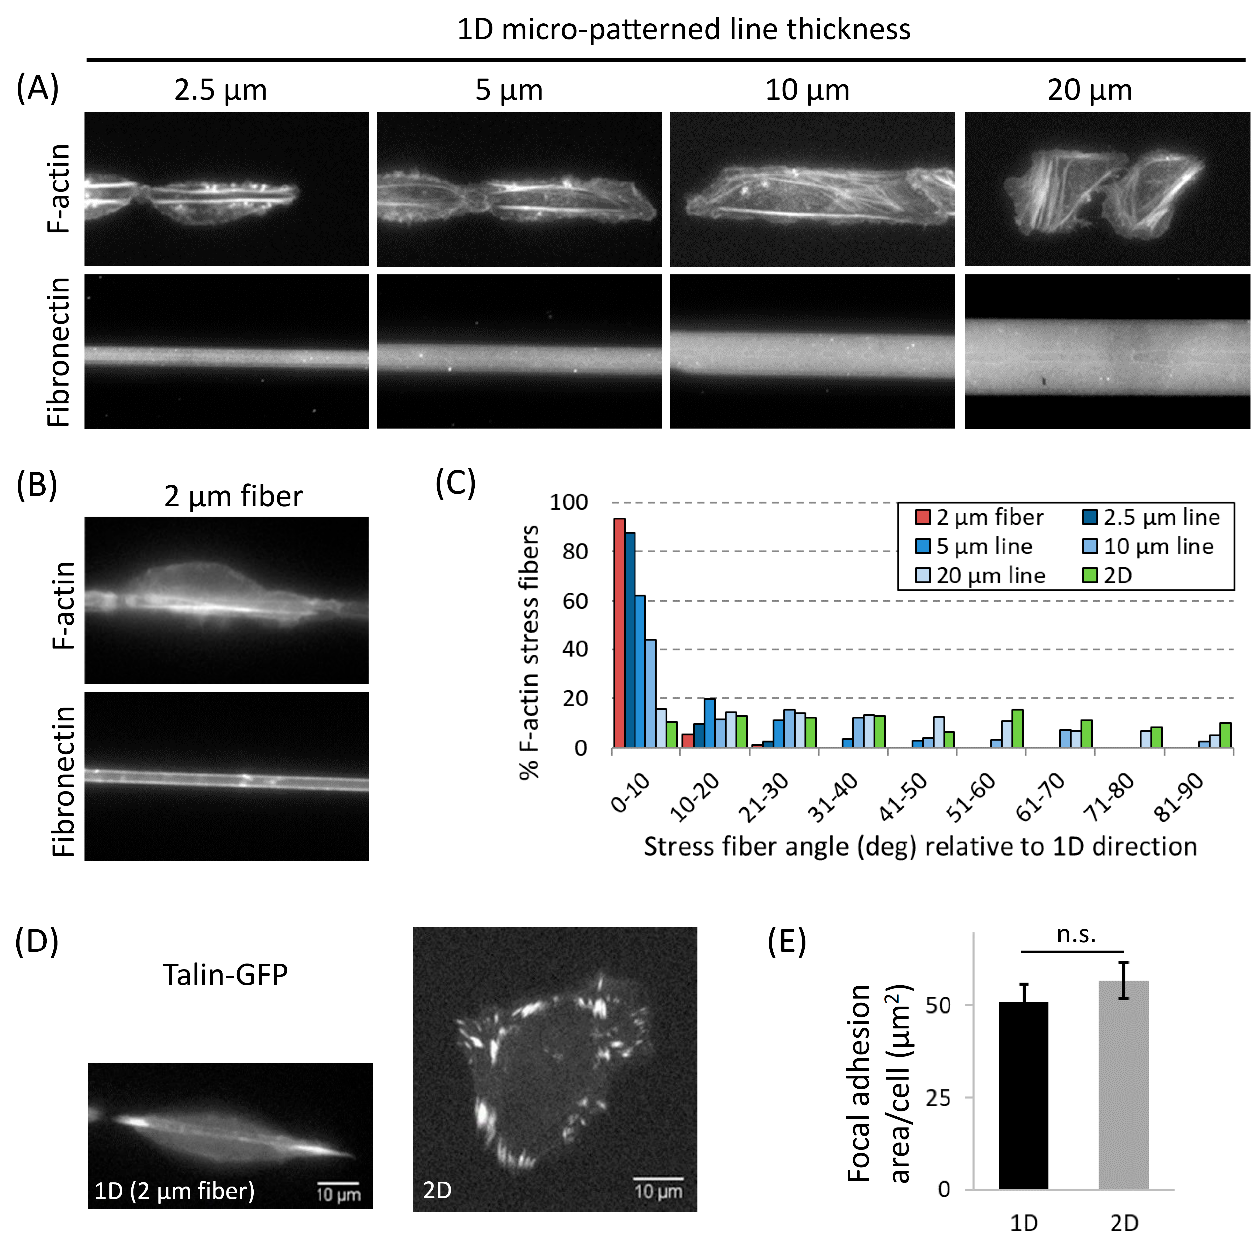
Figure 4. Enhanced alignment of F-actin stress fibers and focal adhesions in tumor cells moving in 1D. ( A ) F-actin staining in tumor cells moving on different thickness micro-patterned 1D lines (2.5, 5, 10, and 20 µ m). ( B ) F-actin staining in tumor cell moving on fibronectin-coated 2 µ m polymeric fiber. ( C ) Quantification of the proportion of F-actin stress fibers (from all cells in each condition) aligned at the specific angle with respect to the 1D axis shown as histogram plot for each condition. Angles 0 and 90 degrees represent the direction parallel and perpendicular to the 1D axis, respectively. n = 90, 81, 106, 123, 158, and 170 F-actin stress fibers analyzed in 12, 14, 12, 13, 13, 12 cells on 2 µ m fiber, 2.5 µ m line, 5 µ m line, 10 µ m line, 20 µ m line and in 2D, respectively. ( D ) Focal adhesion (CellLight Talin-GFP) distribution in tumor cells shows aligned focal adhesions in cells moving in 1D (2 µ m fibers) vs. randomly oriented focal adhesions in cells moving in 2D. ( E ) Quantification of total focal adhesion area/cell in cells moving in 1D (2 µ m fibronectin-coated polymeric fibers) and 2D (fibronectin-coated). Data plotted as mean ± SEM, n = 23 and 20 cells for the 1D and 2D conditions, respectively.